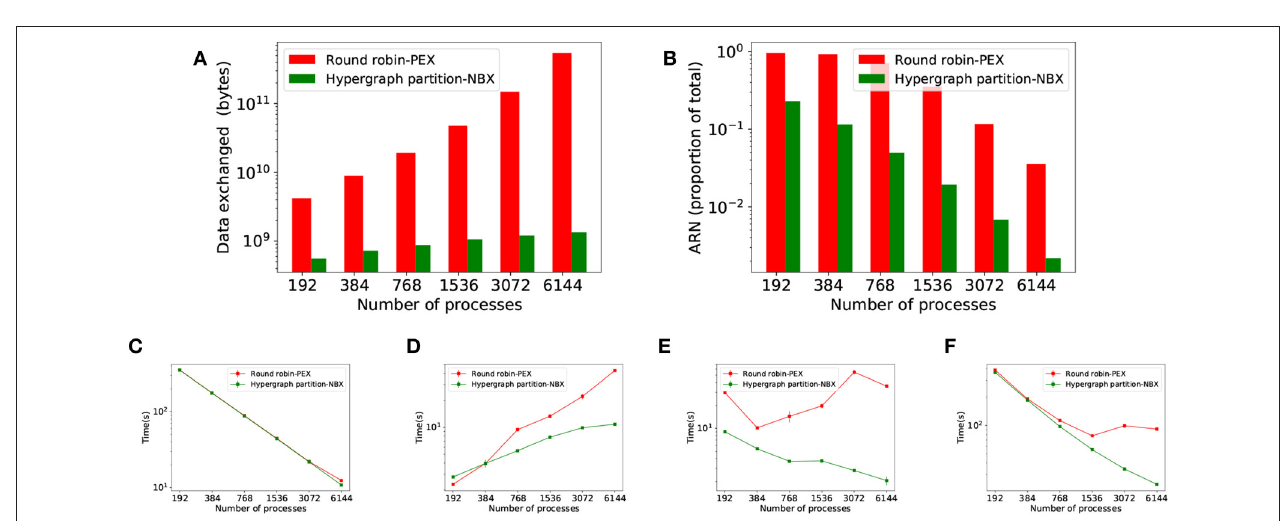
( Figure 9B ) brought by the use of NBX , as well as a reduction of data exchange time of Hypergraph partition-NBX over Rand- NBX —see discussion in section 4.3 for an in depth